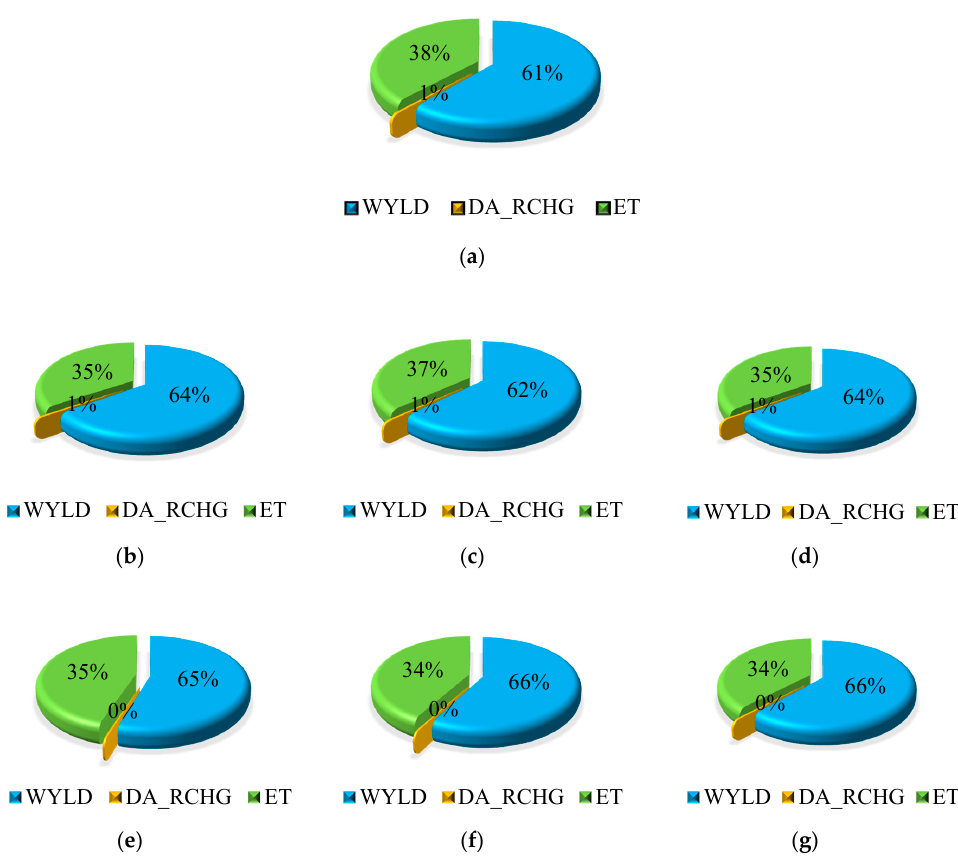
Figure 5. Relative percentages of water balance components under baseline and future periods ( a ) baseline period; ( b ) early century RCP 4.5; ( c ) mid-century RCP 4.5; ( d ) late century RCP 4.5; ( e ) early century RCP 8.5; ( f ) mid-century RCP 8.5; ( g ) late century RCP 8.5. ( Note: WYLD refers to water yield,